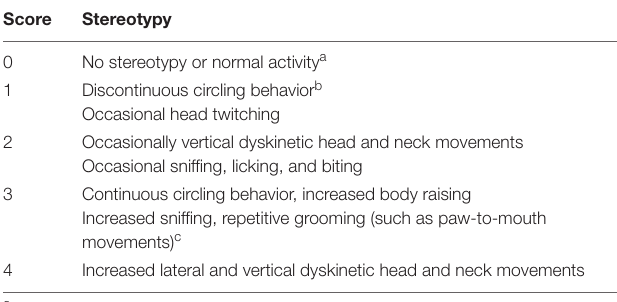
TABLE 1 | Behavior measurements referring to evaluating grades of